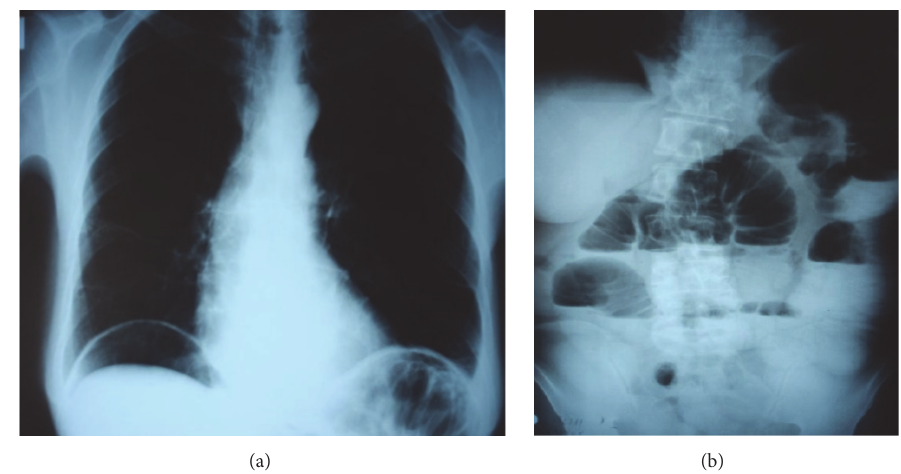
Figure 3: Abdominal X-ray after colonoscopy and clinical deterioration. Presence of free abdominal gas.